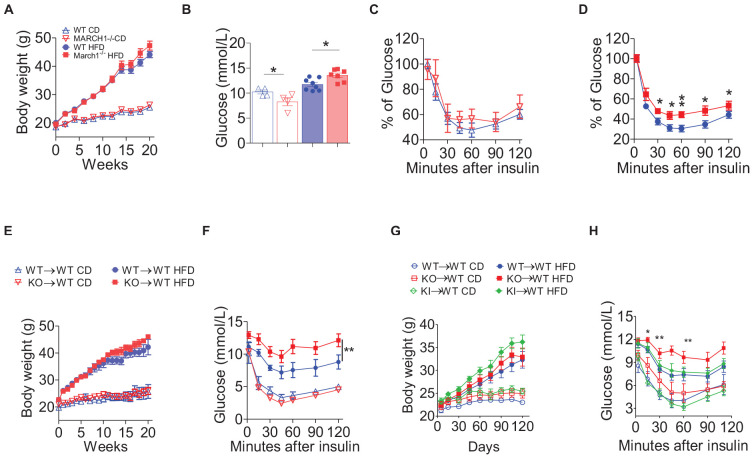
March1 deficiency exacerbates obesity-induced insulin resistance. Mice were fed control diet (CD) or high-fat diet (HFD) and tested for fasting glucose and insulin tolerance (ITT). (A) Body weight gain, (B) fasting glucose, and (C,D) ITT of WT and March1–/– mice after 20 weeks. (E–G) Six week old WT mice were lethally irradiated and received an i.v. injection of bone marrow cells from March1–/– or WT mice. After 8 weeks of reconstitution, these WT BMC (WT→WT) and March1-/-BMC (KO→WT) were fed CD or HFD for 20 weeks. (E) Body weight gain and (F) ITT performed on body weight-matched mice. Experiment was repeated twice. In another independent experiment, MHCII KI BMC (KI→WT) were included. Body weight gain was measured during 16 weeks of feeding (G) and body weight-matched mice were submitted to an ITT (H). *P < 0.05 and **P < 0.01.